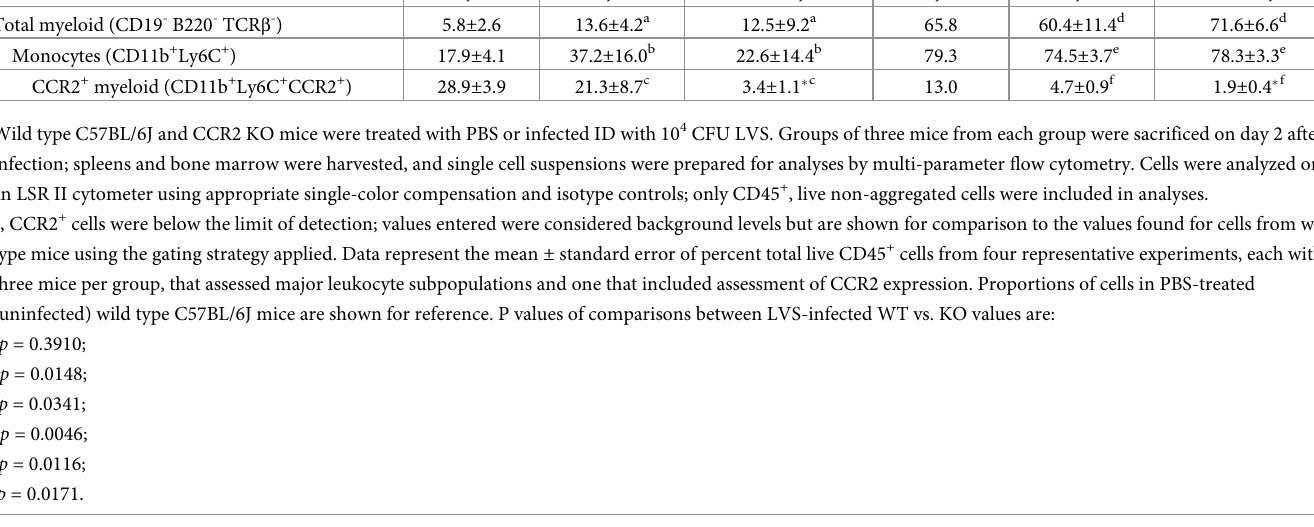
Percent of cells with the indicated